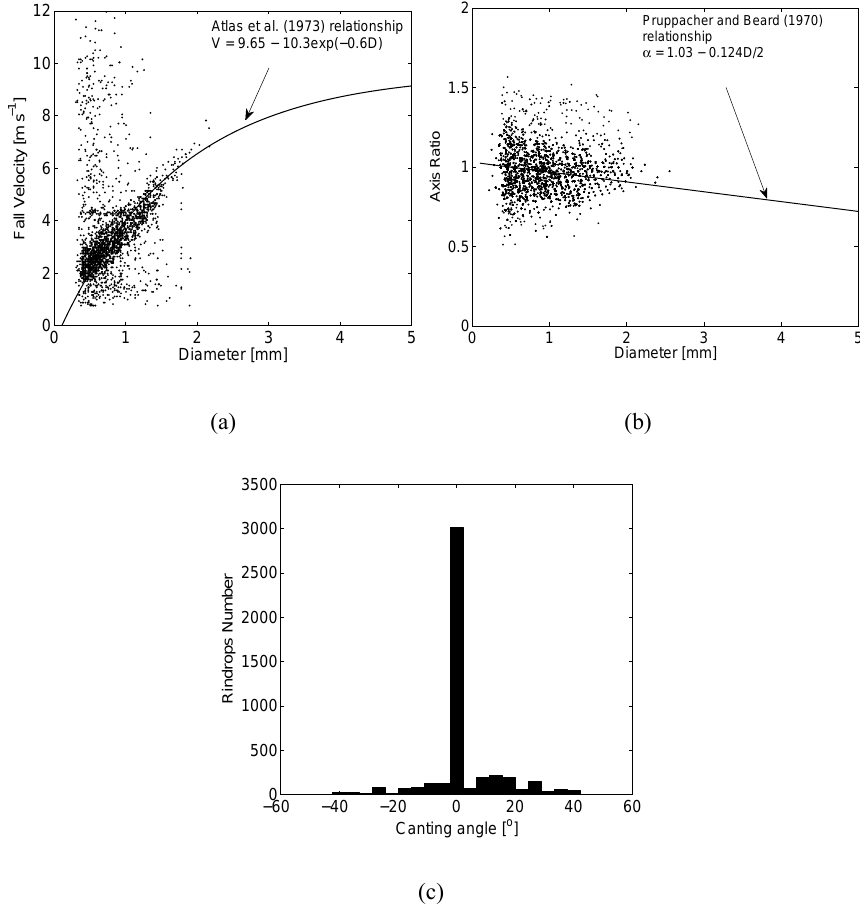
Figure 11. Fall velocity, axis ratio, and canting angle of raindrops observed by VPS.